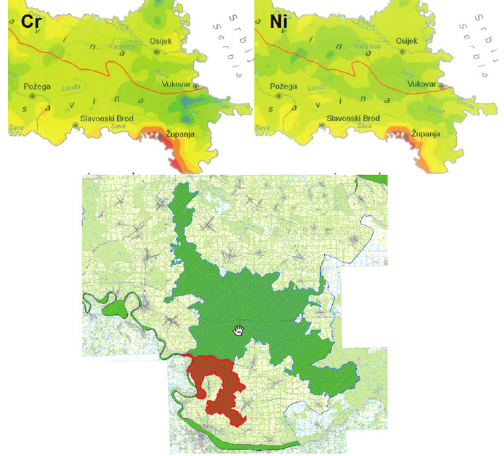
FIGURE 5. High concentrations of chromium